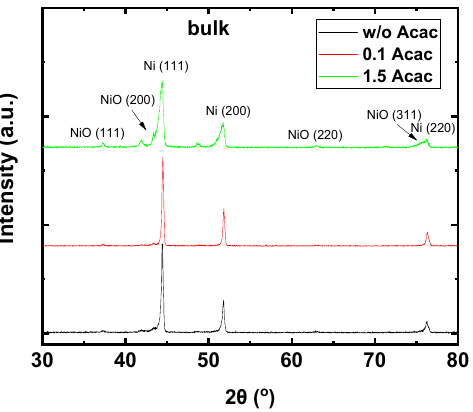
Figure 5. XRD patterns of combustion-synthesized samples (bulk) prepared from precursors containing w/o, 0.1, and 1.5 molar ratio of fuel (Acac) to oxidizer (Cu, Ni nitrates) annealed at 200 °C.